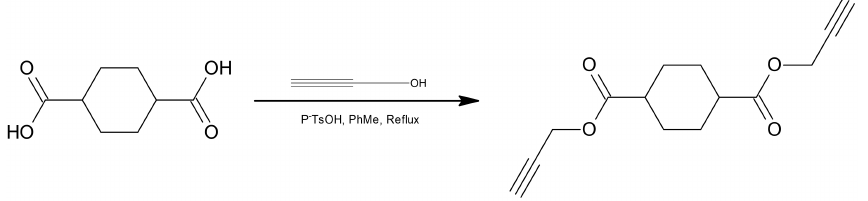
Figure 10. Schematic representation of the synthesis of BPHA.